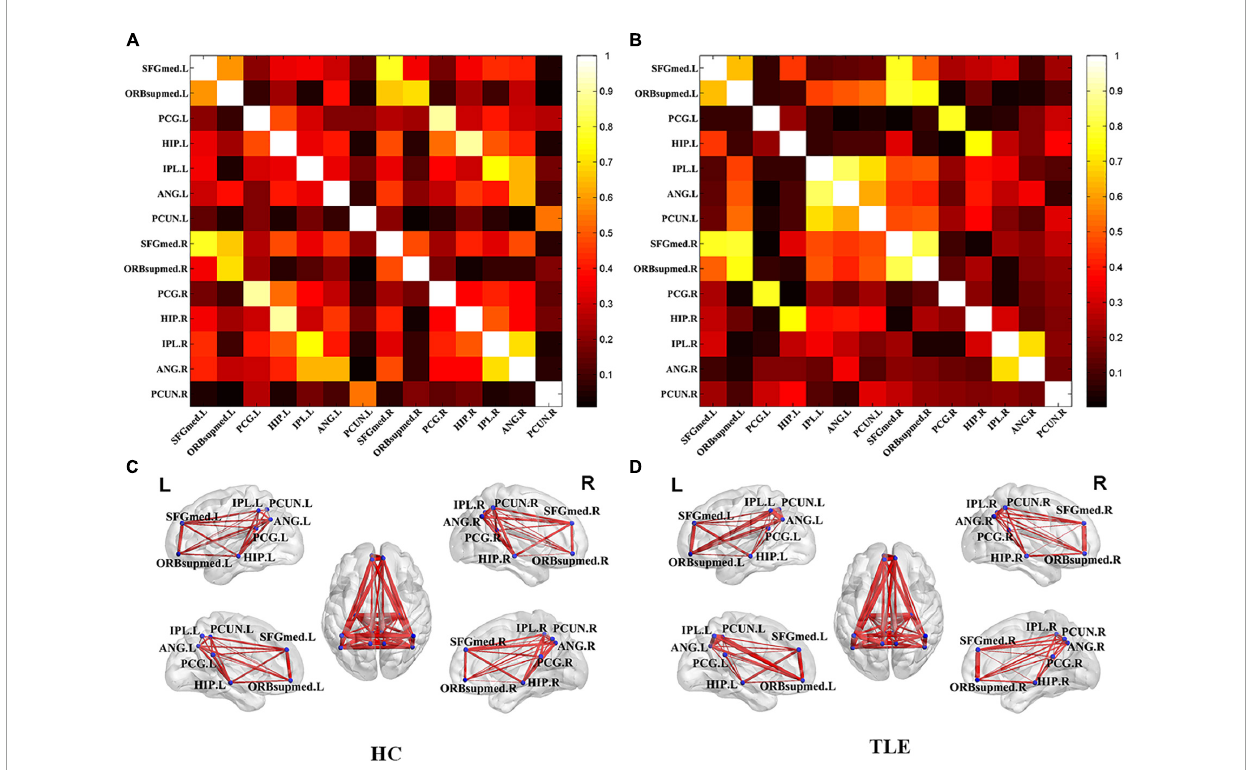
FIGURE1 Metabolic correlation network of the TLE and HC groups. The left panel was the connectivity matrix (A) and connectivity graph (C) of the HC group. The left panel was the connectivity matrix (B) and connectivity graph (D) of the TLE group. The nodes of VOIs by blue dots and connection strength is represented by the thickness of each line connecting two nodes. TLE, temporal lobe epilepsy; HC, healthy